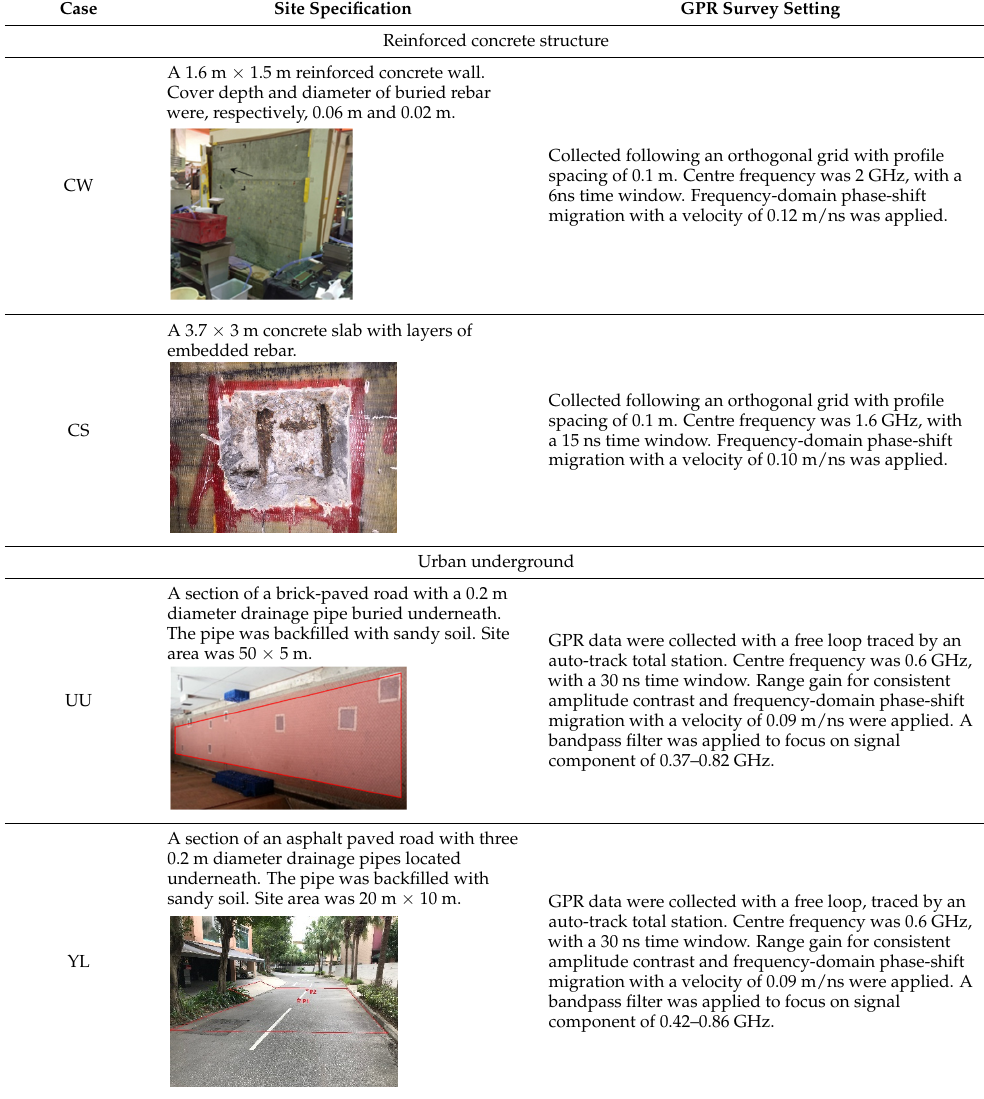
Table 1. Specifications of representative cases.